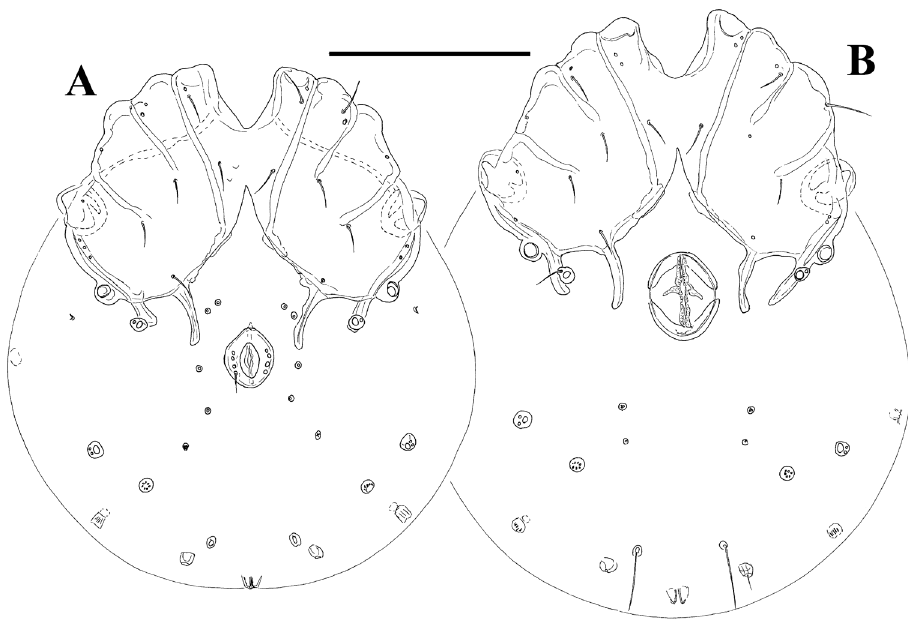
Figure 1. Litarachna lopezae sp. n., Bajo de Sico ( A male, B female): idiosoma, ventral view. Scale bar = 100